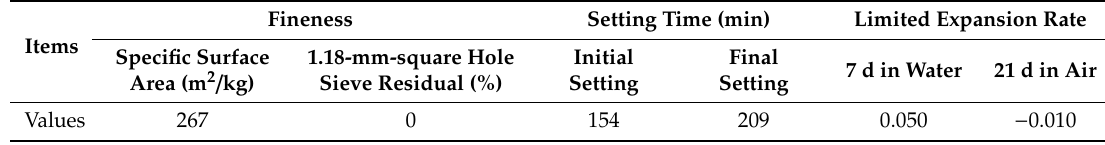
Table 3. The properties of the U-type expansive agent (UEA) used in this study.